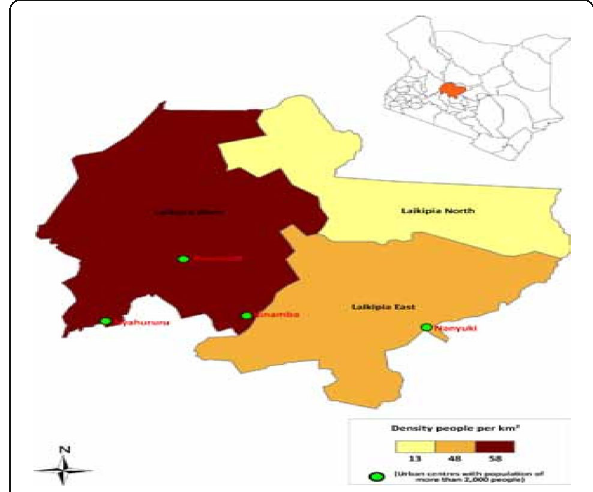
Figure 1 Administrative map of Laikipia County. The inset shows the map of